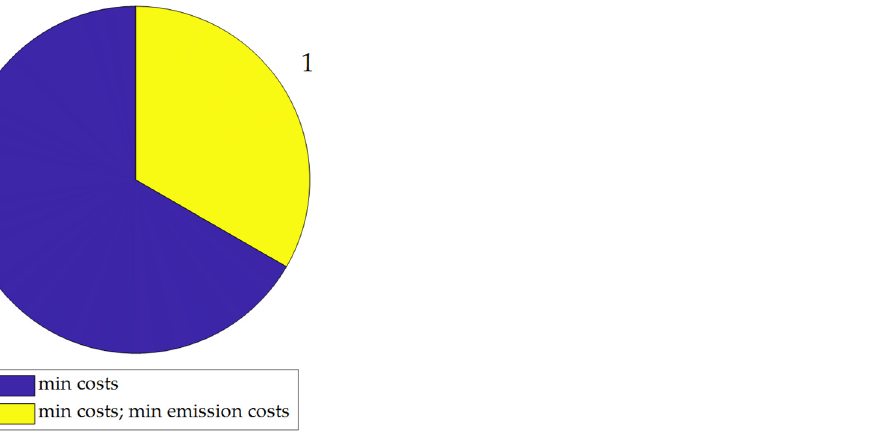
Figure 8. Number of selected papers associated with a given objective for robust